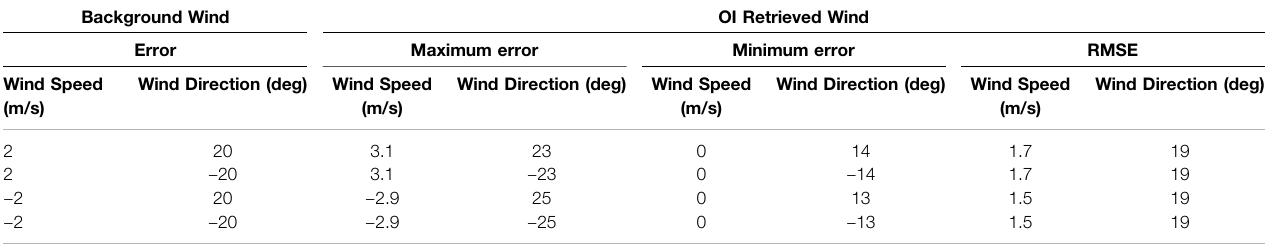
TABLE 2 | Comparison of optimal interpolation (OI) retrieved wind speed and direction errors under different error conditions for the background wind speed and direction. Background Wind